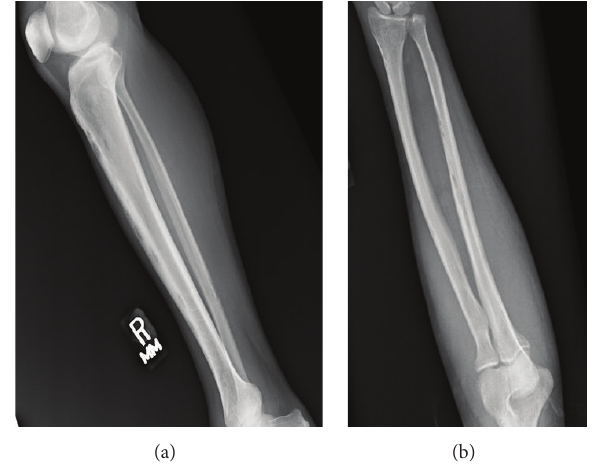
Figure 2: Plain radiographs of right tibia/fibula (a) and left forearm (b) showing multifocal region of cortical irregularities scattered throughout the